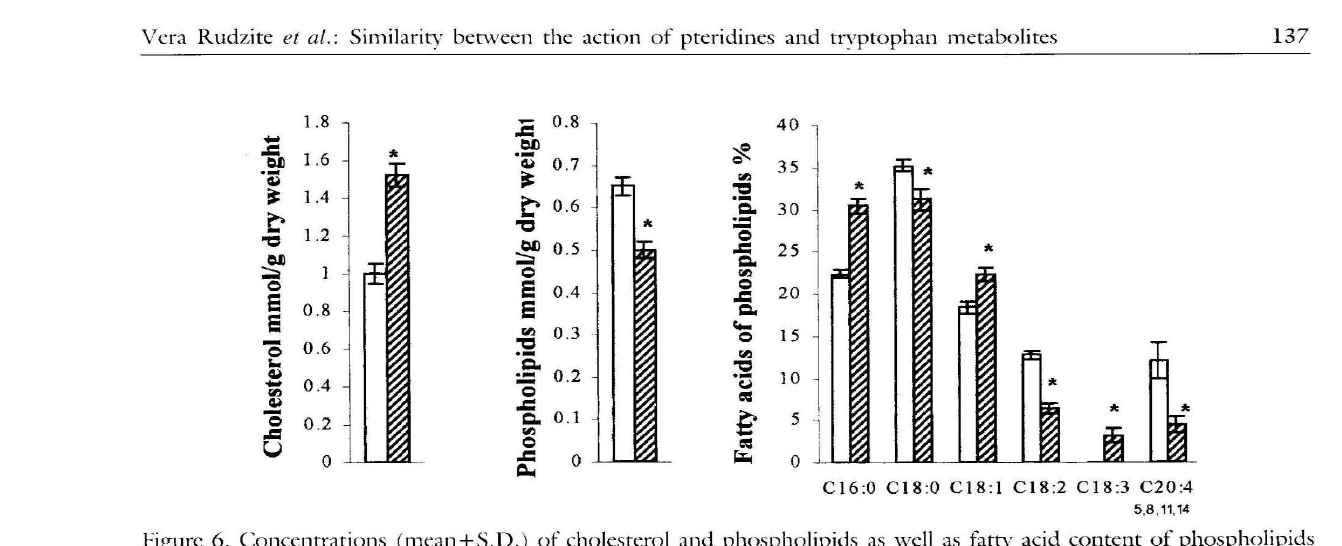
figure 6. Concentrations (mean±S.D.) of cholesterol and phospholipids as well as fatty acid content of phospholipids (in percent; mean±S.D.) in controls (open bars) and in samples with 4 nmoljg wet weight L-kynurenine (hatched bars). Samples of rat liver tissue homogenates were used to test for phospholipid biosynthesis in vitro. Incubation medium: Krebs - Ringer - phosphate buffer containing 0.3% albumin (pH=7.4), fatty acid mixture and glycerol. Samples ,,,ere incubated twice for 4 h at 37'C. *The changes are statistically significant (p<0.05 -p<O.OOl ).